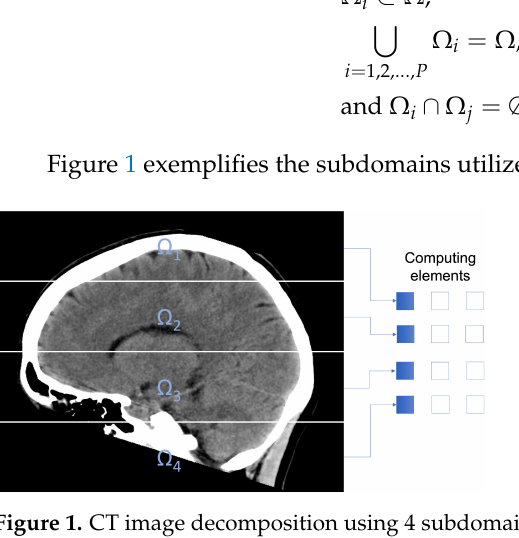
Figure 1. CT image decomposition using 4 subdomains.